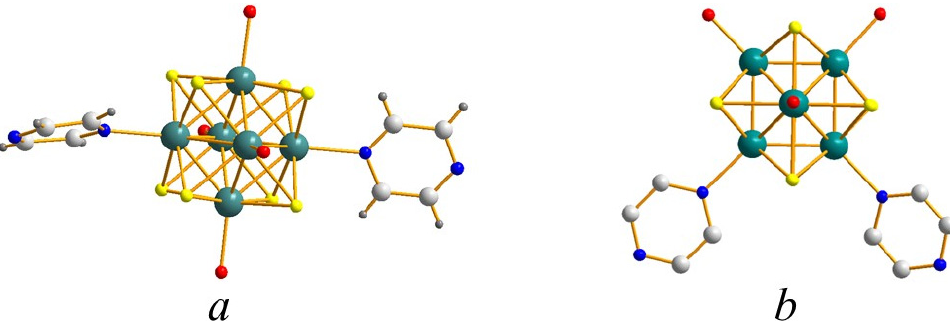
Figure 1. View of the cluster unit [Re 6 S i8 (Pz) a2 (OH) a4 − x (H 2 O) ax ] x − 2 in ( a ) trans and ( b ) cis configurations. Red atoms stand for either hydroxyl groups or water molecules.